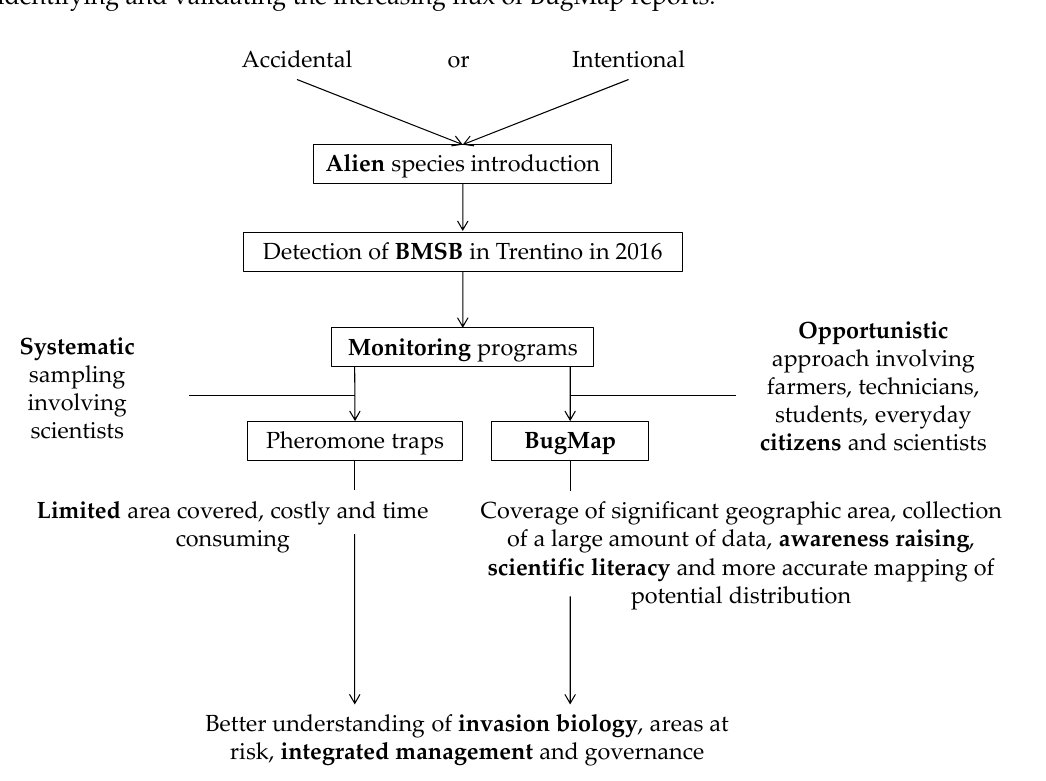
Figure S1: BugMap flyer, Figure S2: BugMap real time tracking, Figure S3: Citizen monitoring and traditional monitoring, Figure S4: Jackknife test for variable contribution, Table S1: land use classes, Table S2: Travel-time